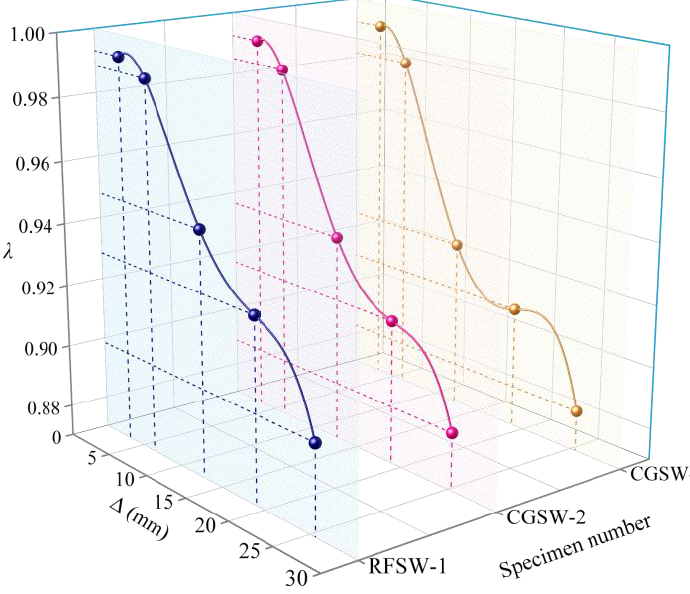
Figure 14. Strength degradation curves of the specimens.